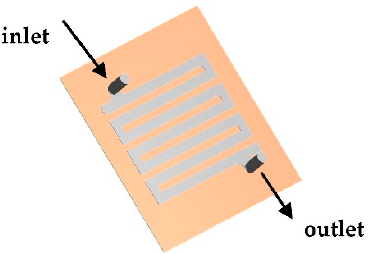
Figure 1. Top-down view of the simulated geometry. Top side is the inlet and bottom side is the outlet. Three distinct zones in the geometry were created: an inflow zone, outlet zone and membrane zone. The inflow zone represents the inlet of the module connected to the flow path through a spacer and a retentate outlet, the outflow zone, found on the other side of the membrane zone and a membrane zone, found at the other side of the spacer when compared to the inlet as shown in Figure 2.